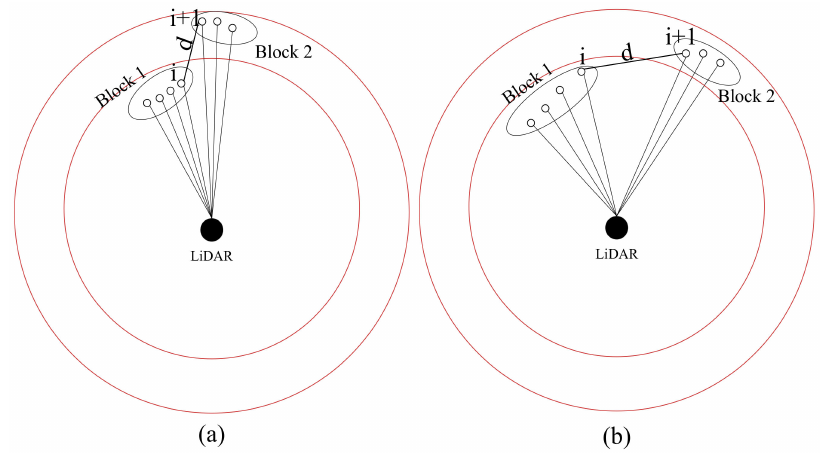
Figure 6. Laser-point cloud blocks cannot be merged. Calculate using points i and i +1, d is the distance between the two points. ( a ) The angle threshold is met, but the distance threshold is not. ( b ) The angle threshold is not met.